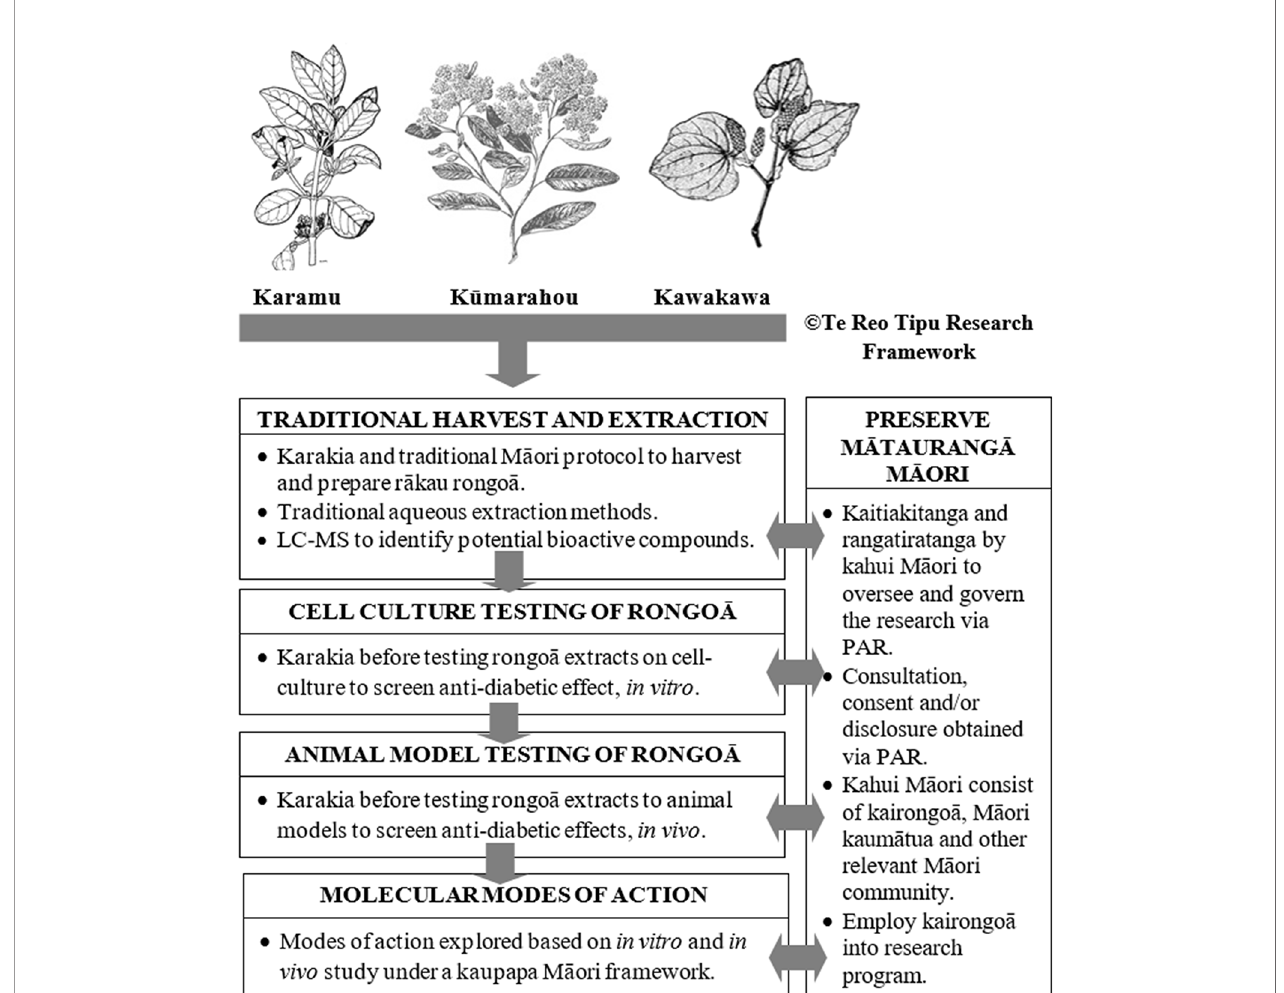
FIGURE 2 | Te Reo Tipu Research - Kaupapa Ma ̄ ori molecular research scheme to study clinically proven karamu, ku ̄ marahou and kawakawa ra ̄ kau rongoa ̄ used for T2DM ‘ mate huka ’ . This fi gure is original. The karamu, k ū marahou and kawakawa images were obtained from Te Ara: The Encyclopedia of New Zealand, which